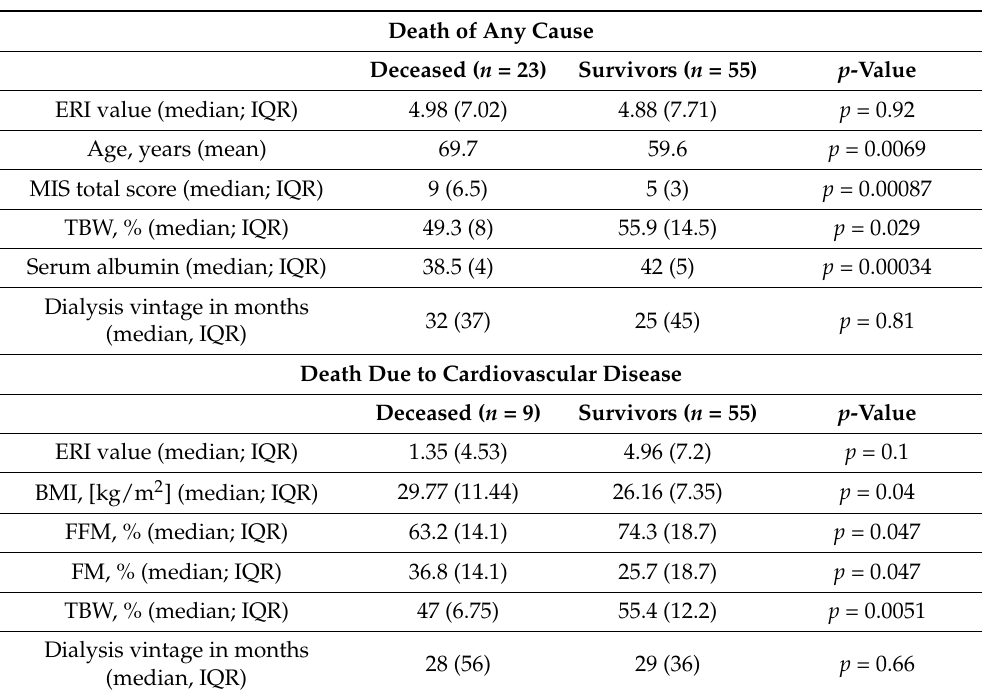
Table 6. Comparison of survivors and deceased in terms of ERI, body composition, dialysis vintage and significant laboratory findings (U-Mann-Whitney test, IQR—interquartile